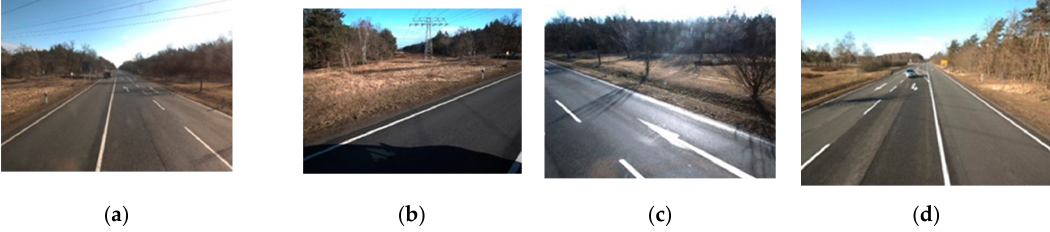
Figure 2. Perspectives of the four cameras mounted on the mobile mapping vehicle: images taken with (a) front, (b) left, (c) right, and (d) rear camera. As the vehicle moves forward, it captures the road surface from different angles.